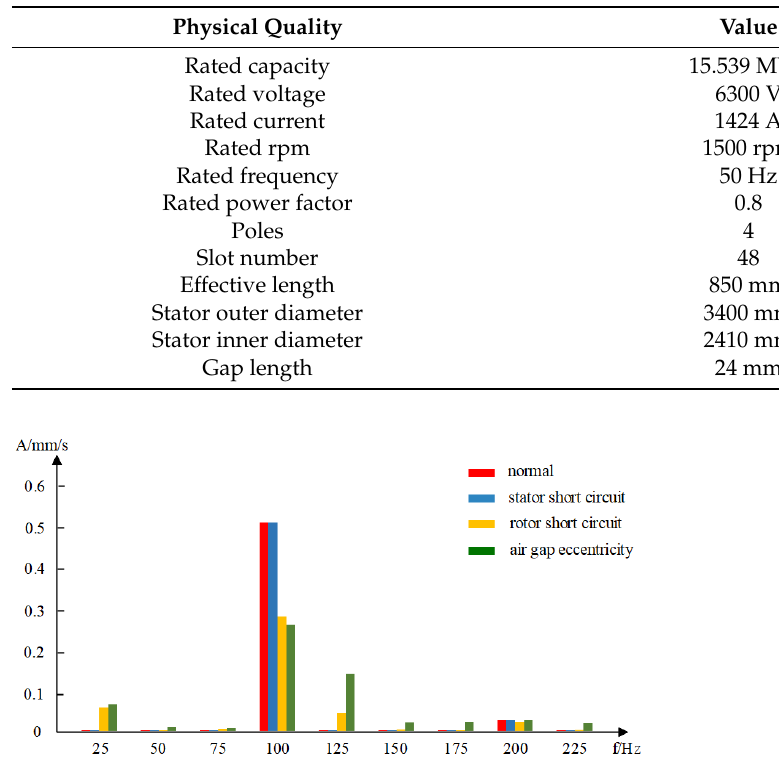
Figure 2. FEA model of the generator.